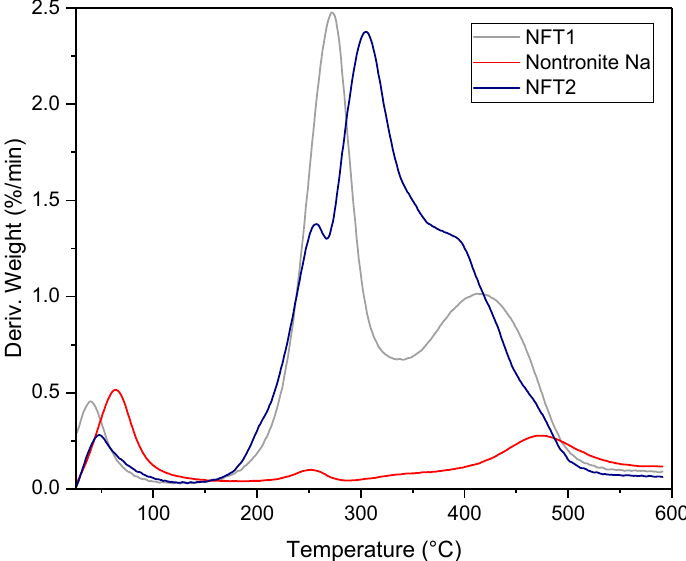
Figure 12. DTG plot of treated clay and organoclays.